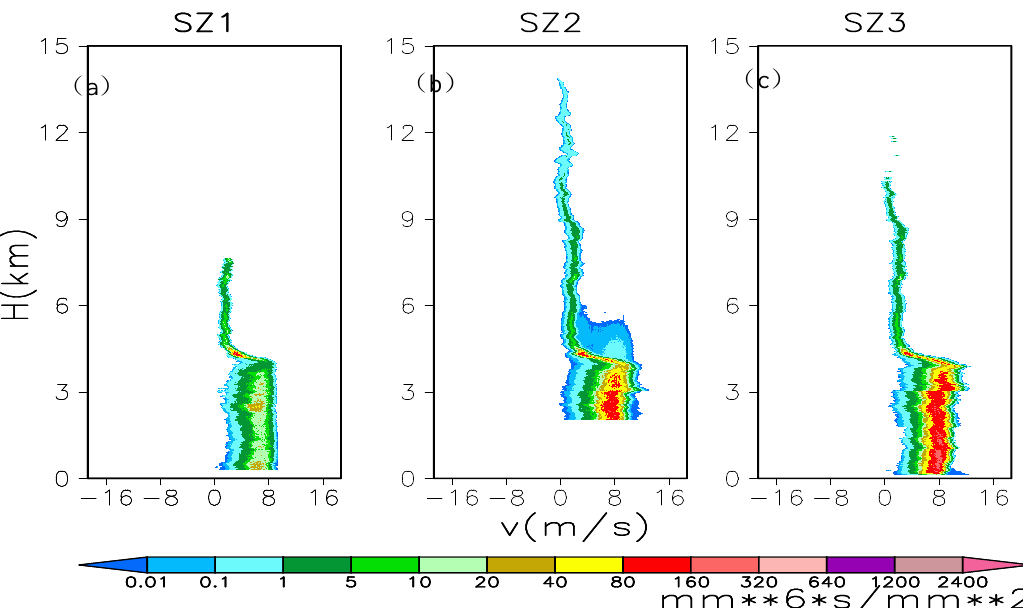
Figure 7. The same data as shown in Figure 3 but for dealiased SZ1, SZ2, and SZ3.